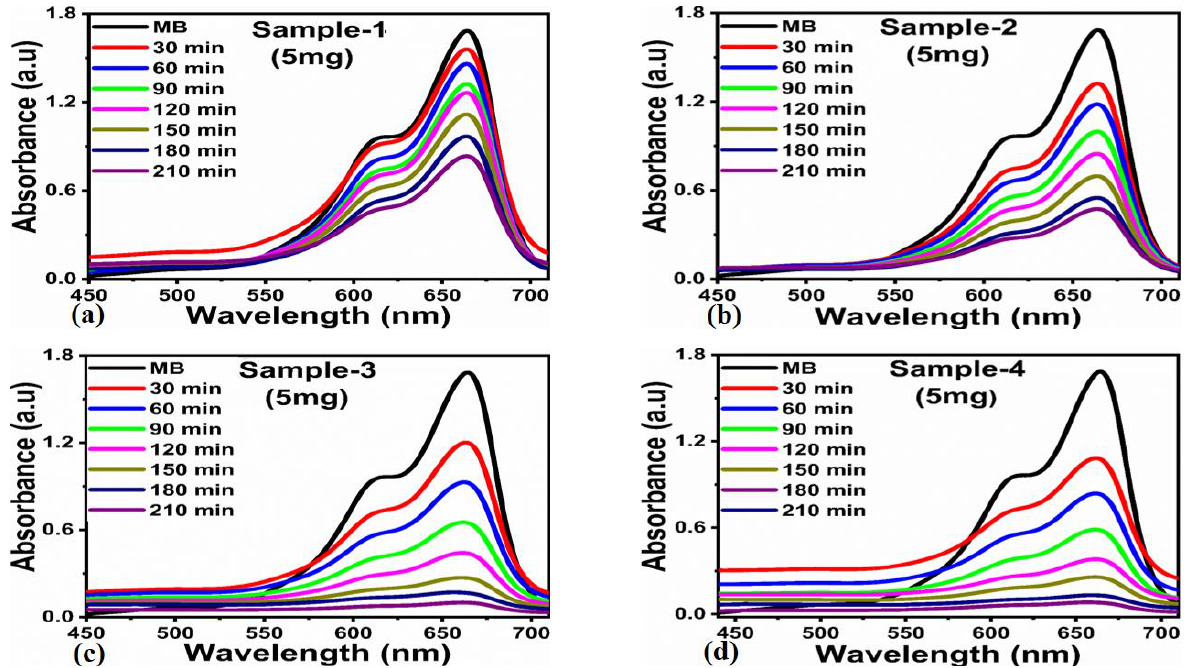
Figure 6. ( a – d ) UV-visible absorption spectra of photodegradation of 8.22 × 10 −5 M) MB solution using catalyst dose of 5 mg of sample-1, sample-2, sample-3, and sample-4 under the irradiation of natural sunlight.